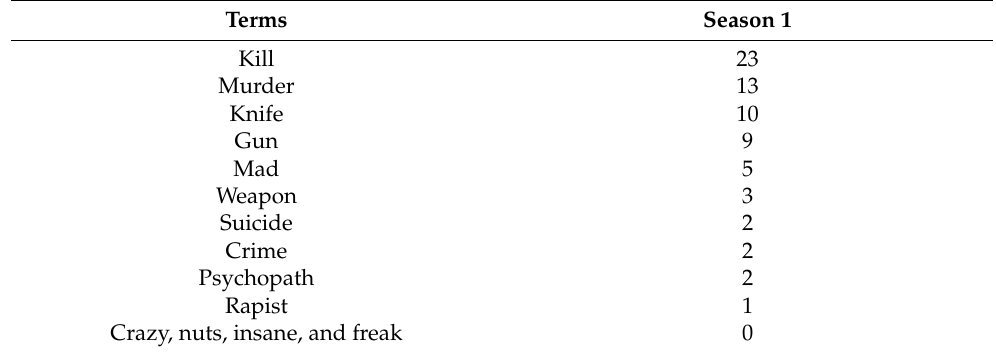
Table 2. Terms used in season 1. Source: